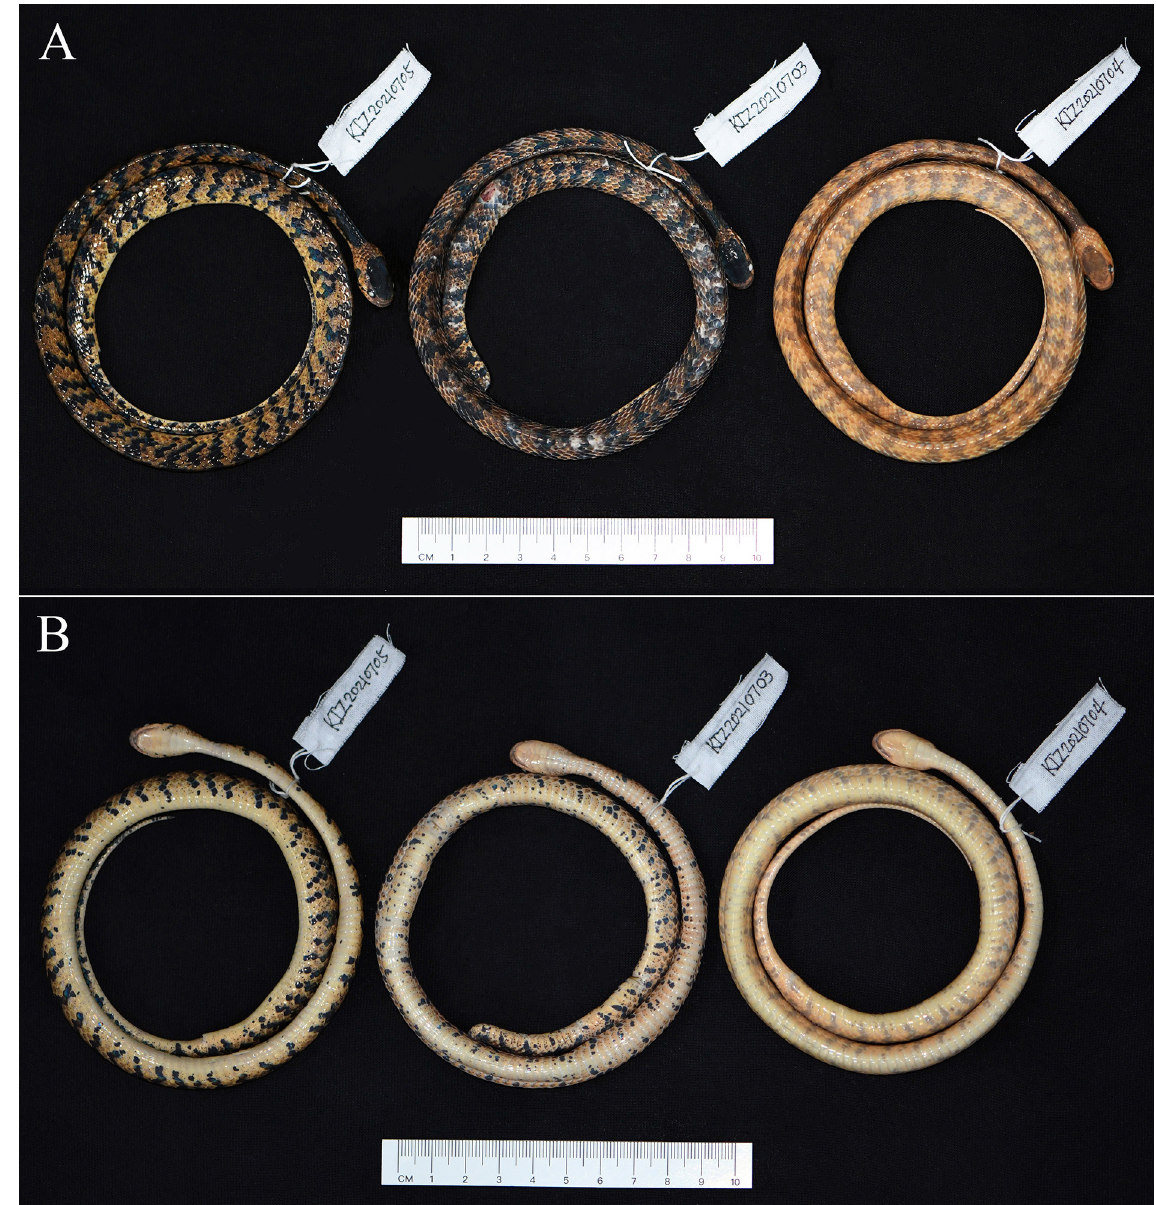
Fig. 5. Pareas tigerinus sp. nov., type specimens in preservative. A . Dorsal views. B . Ventral views. Photos by S.